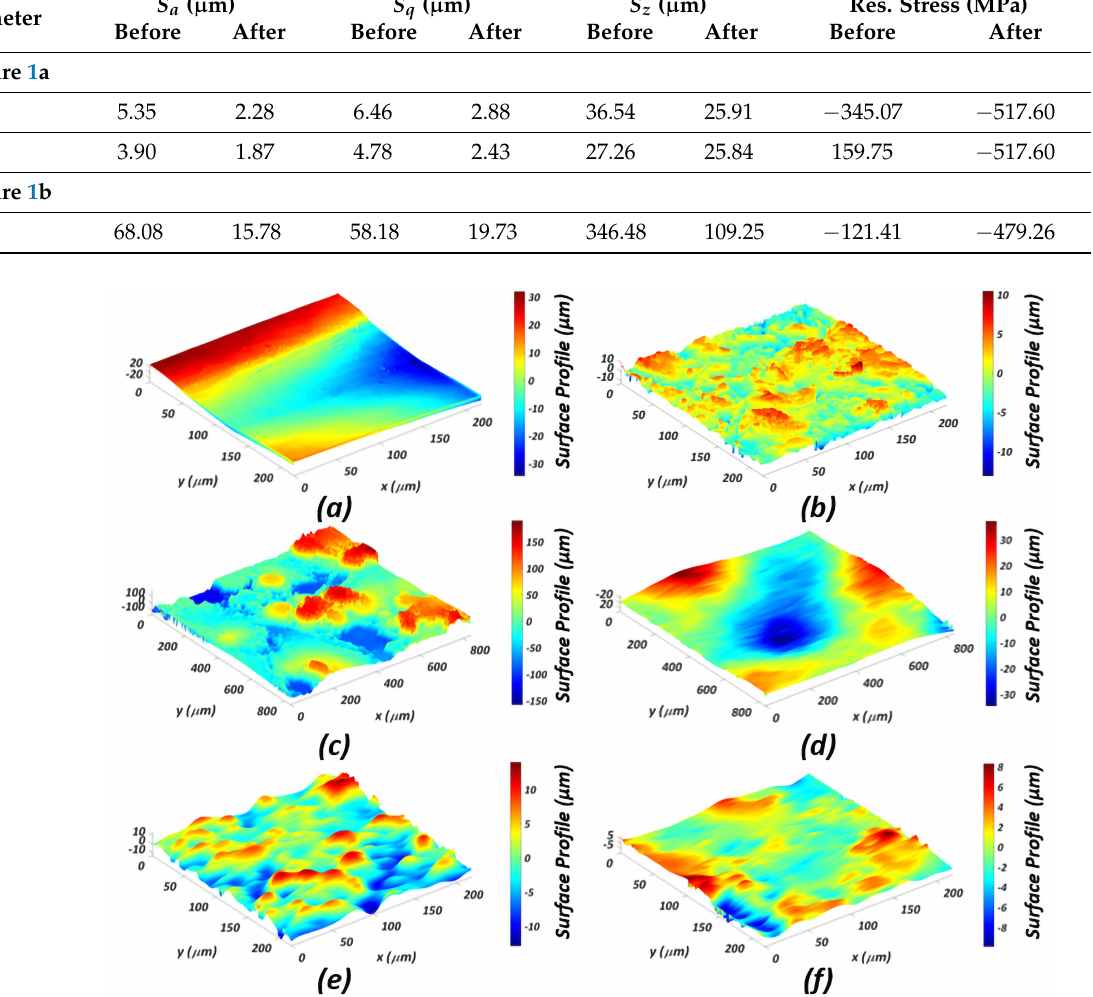
Figure 3. Surface roughness profile of: ( a ) 0 ◦ top surface before bead-blasting; ( b ) 0 ◦ top surface after bead-blasting; ( c ) 30 ◦ top surface before bead-blasting; ( d ) 30 ◦ top surface after bead-blasting; ( e ) EDM surface before bead-blasting; ( f ) EDM surface after bead-blasting. Table 1. Roughness characteristics S a , S q and S z and their surface residual stresses.